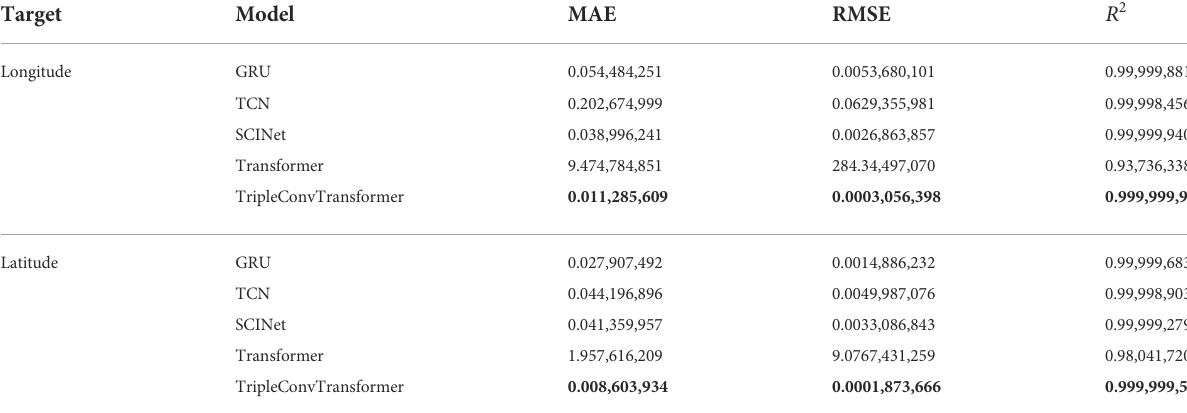
TABLE 5 Prediction results of the fi ve algorithms on longitude and